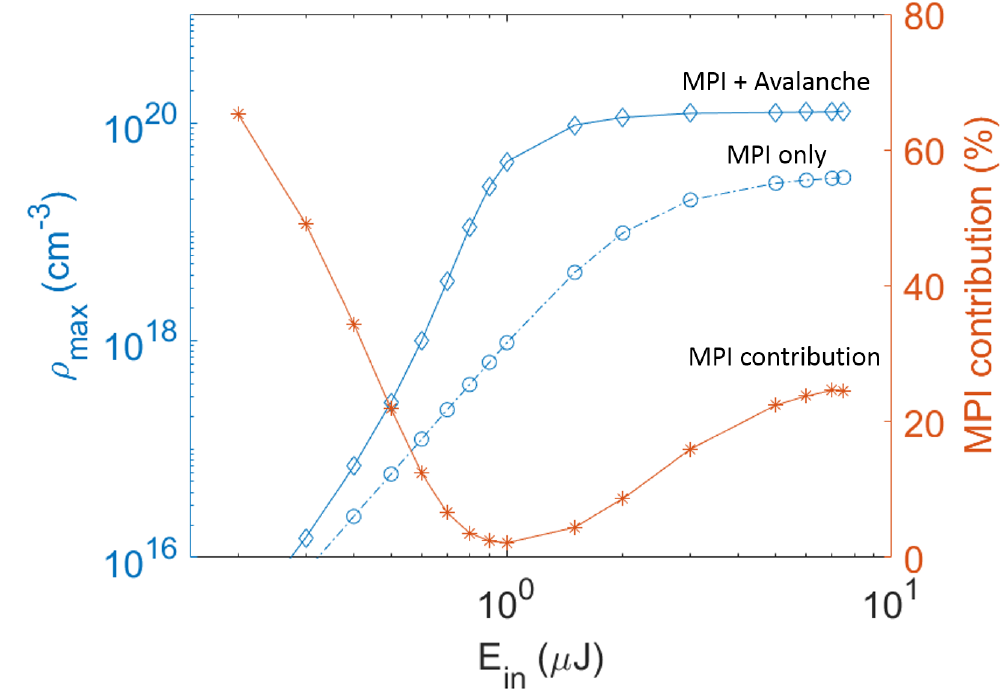
Figure 5. Simulation results of electron density vs. input pulse energy. The maximum electron density is indicated by the left hand side Y axis. The diamond solid line shows electron generation from multiphoton ionization and avalanche ionization. The circle dashed line shows electron genera- tion from multiphoton ionization only. The percentage of electron contribution from multiphoton ionization is indicated by the right hand side Y axis, and plotted as starred solid line in the graph. MPI: multiphoton